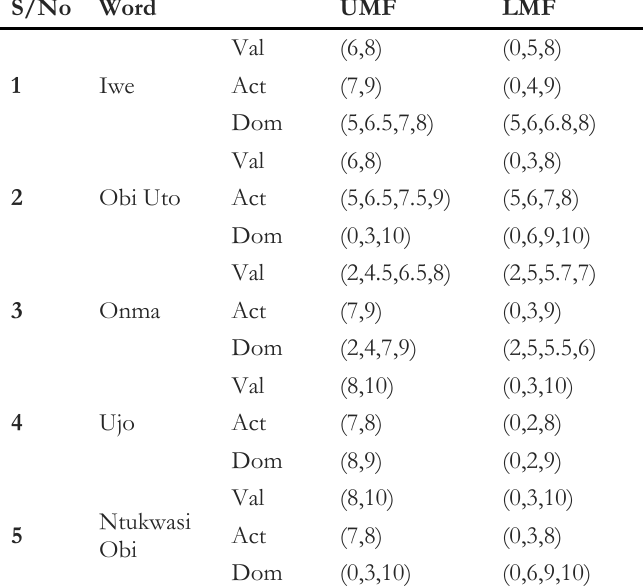
Table 13. Computed LMF and the UMF of the FOU ( 𝐀̃